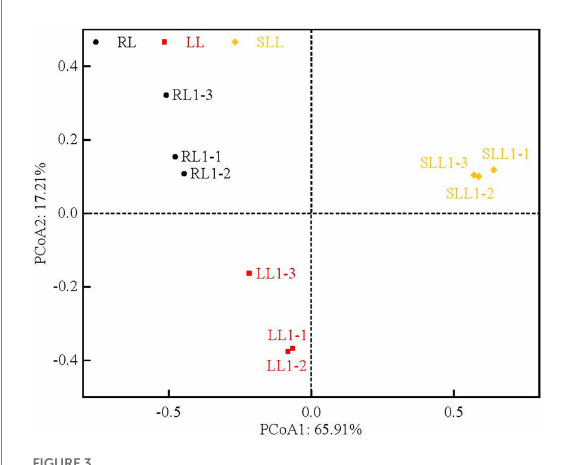
FIGURE 3 Principal component analysis (PCoA) of soil bacterial community diversity based on weighted UniFrac distances among three types of larch forest. LL, Ledum palustre-Larix gmelinii forest; RL, Rhododendron dauricum-Larix gmelinii forest; and SLL, Sphagnum-Bryum-Ledum palustre-Larix gmelinii forest.